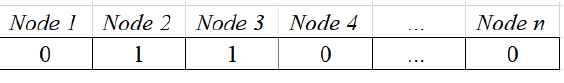
Figure 5. Example of individual.